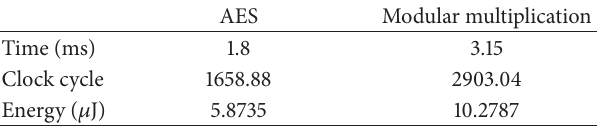
Table 3: Time and energy consumption for different